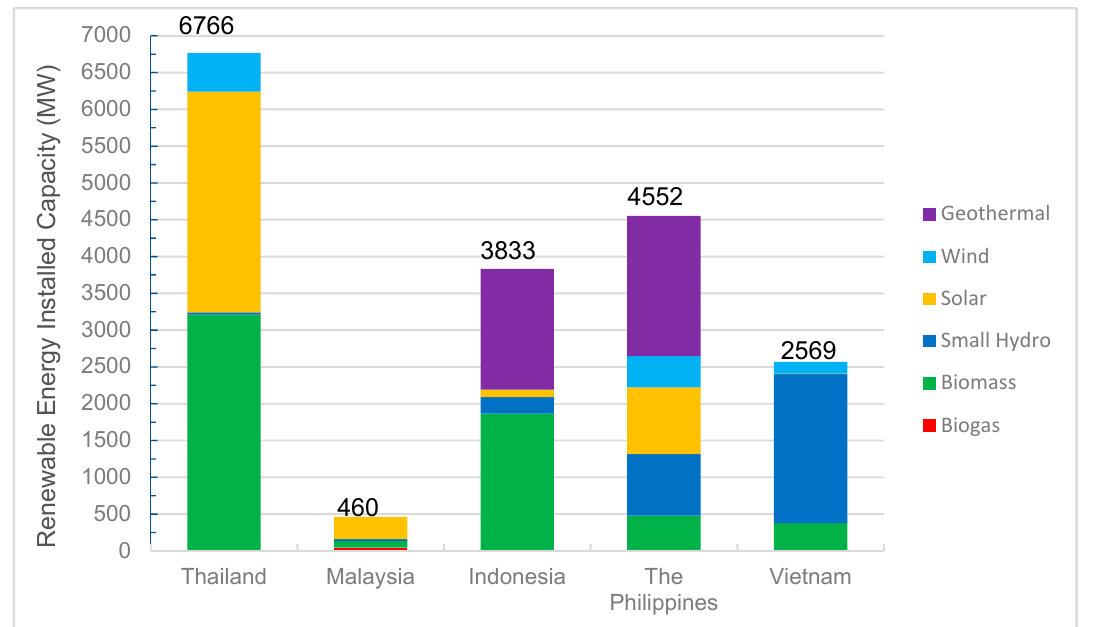
Figure 5. The renewable energy installed capacity in Mega-Watts (MW) of five Southeast Asia countries as of 31 March 2017 [12].